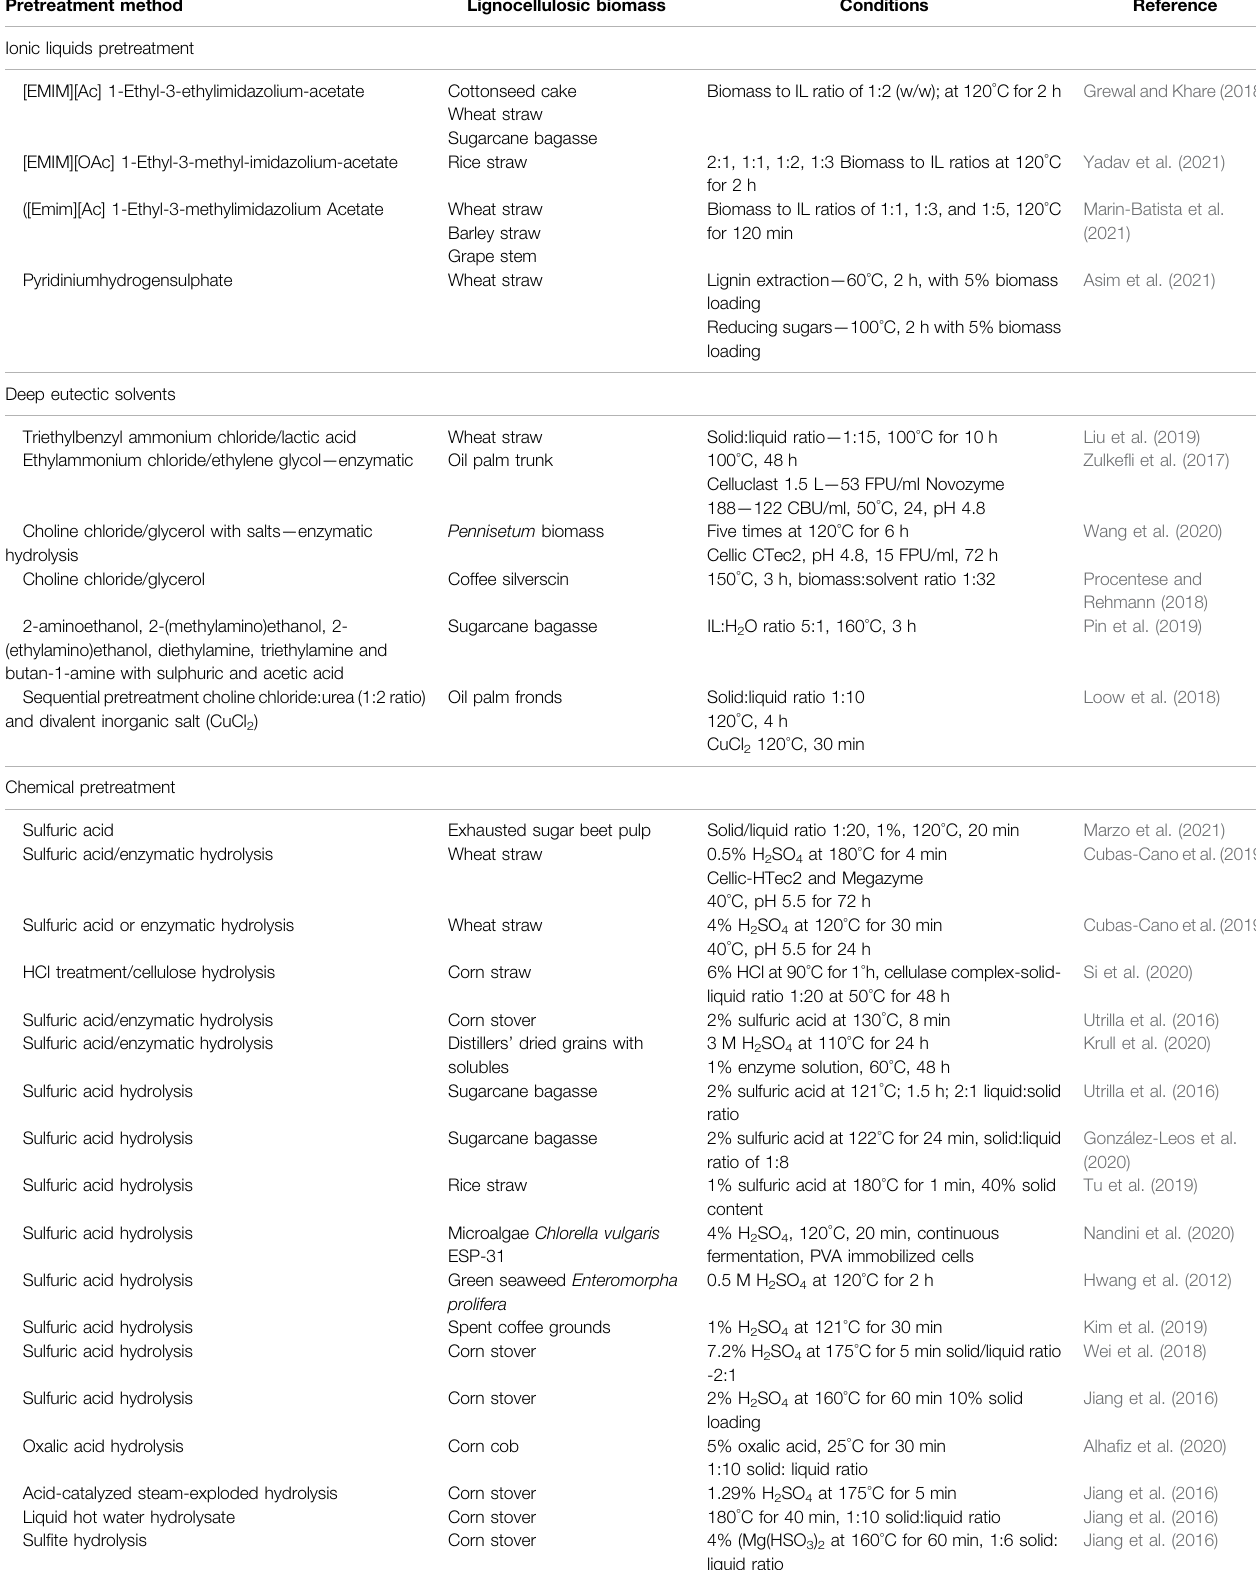
TABLE 3 | Pretreatment methods and conditions of different lignocellulosic